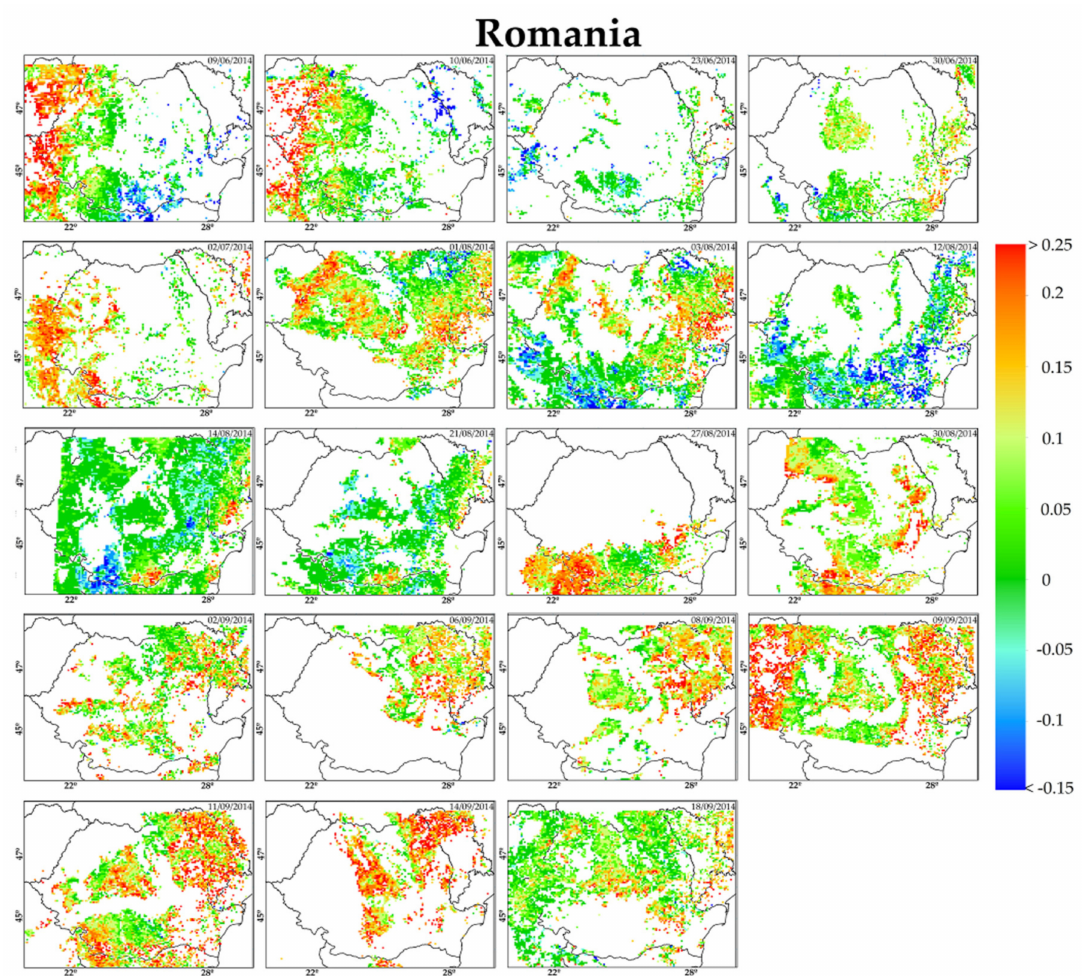
Figure 5. AOD differences between SEVIRI and MODIS for the Romania